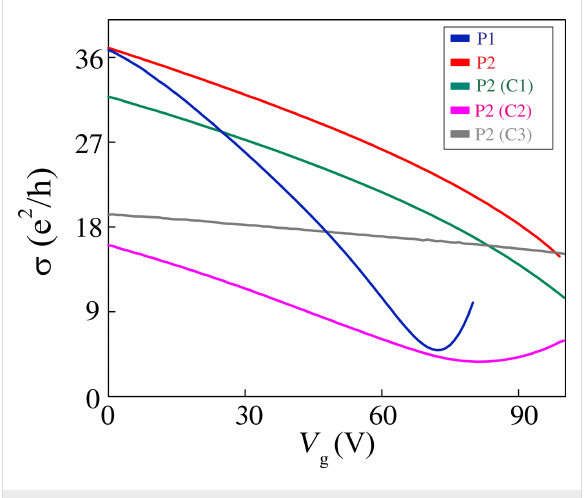
Figure 5: Conductivity σ as a function of the gate voltage V g for graphene devices fabricated by procedures P1 and P2, and for graphene devices produced by procedure P2 and then cleaned by C1, C2 and C3